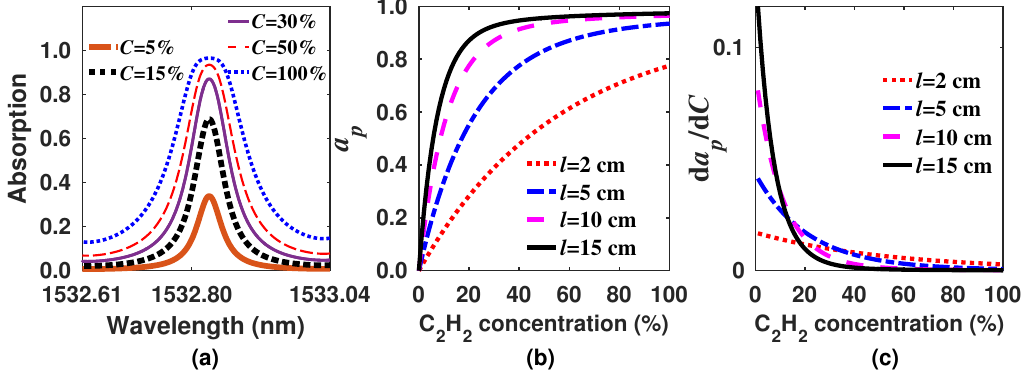
Figure 1. ( a ) Simulated C 2 H 2 absorption spectra considering a pathlength of 10 cm and different concentrations; here, we considered that the laser is scanned over the absorption line; ( b ) peak absorption as a function of the concentration considering different pathlengths; ( c ) sensitivity of the absorption peaks as a function of the C 2 H 2